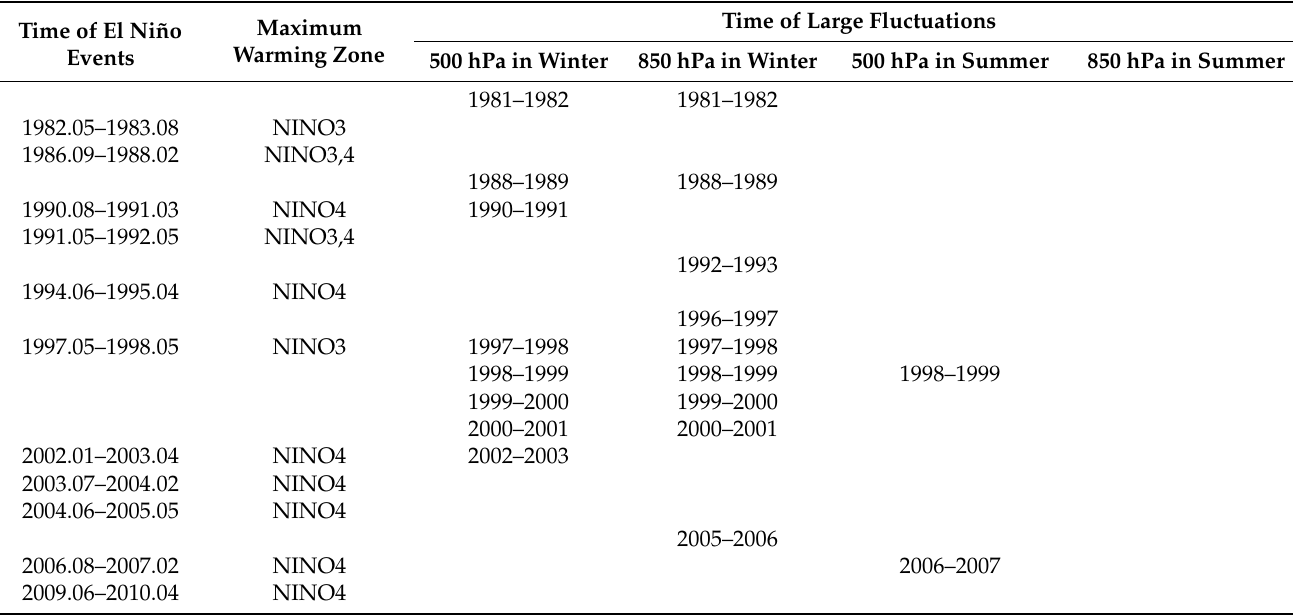
Table 1. The El Niño events and the large fluctuations of time series of vertical motion at over the North Pacific. Time of El